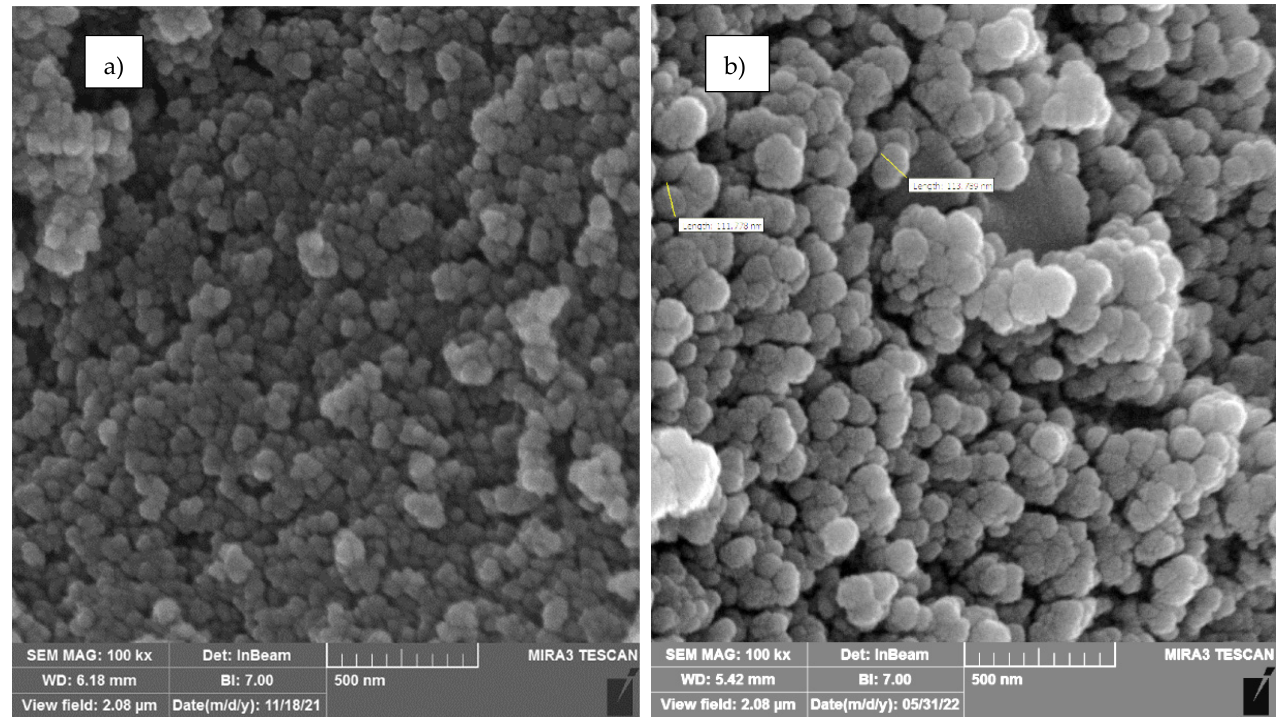
Figure 3. SEM images of ( a ) fumed silica and ( b )